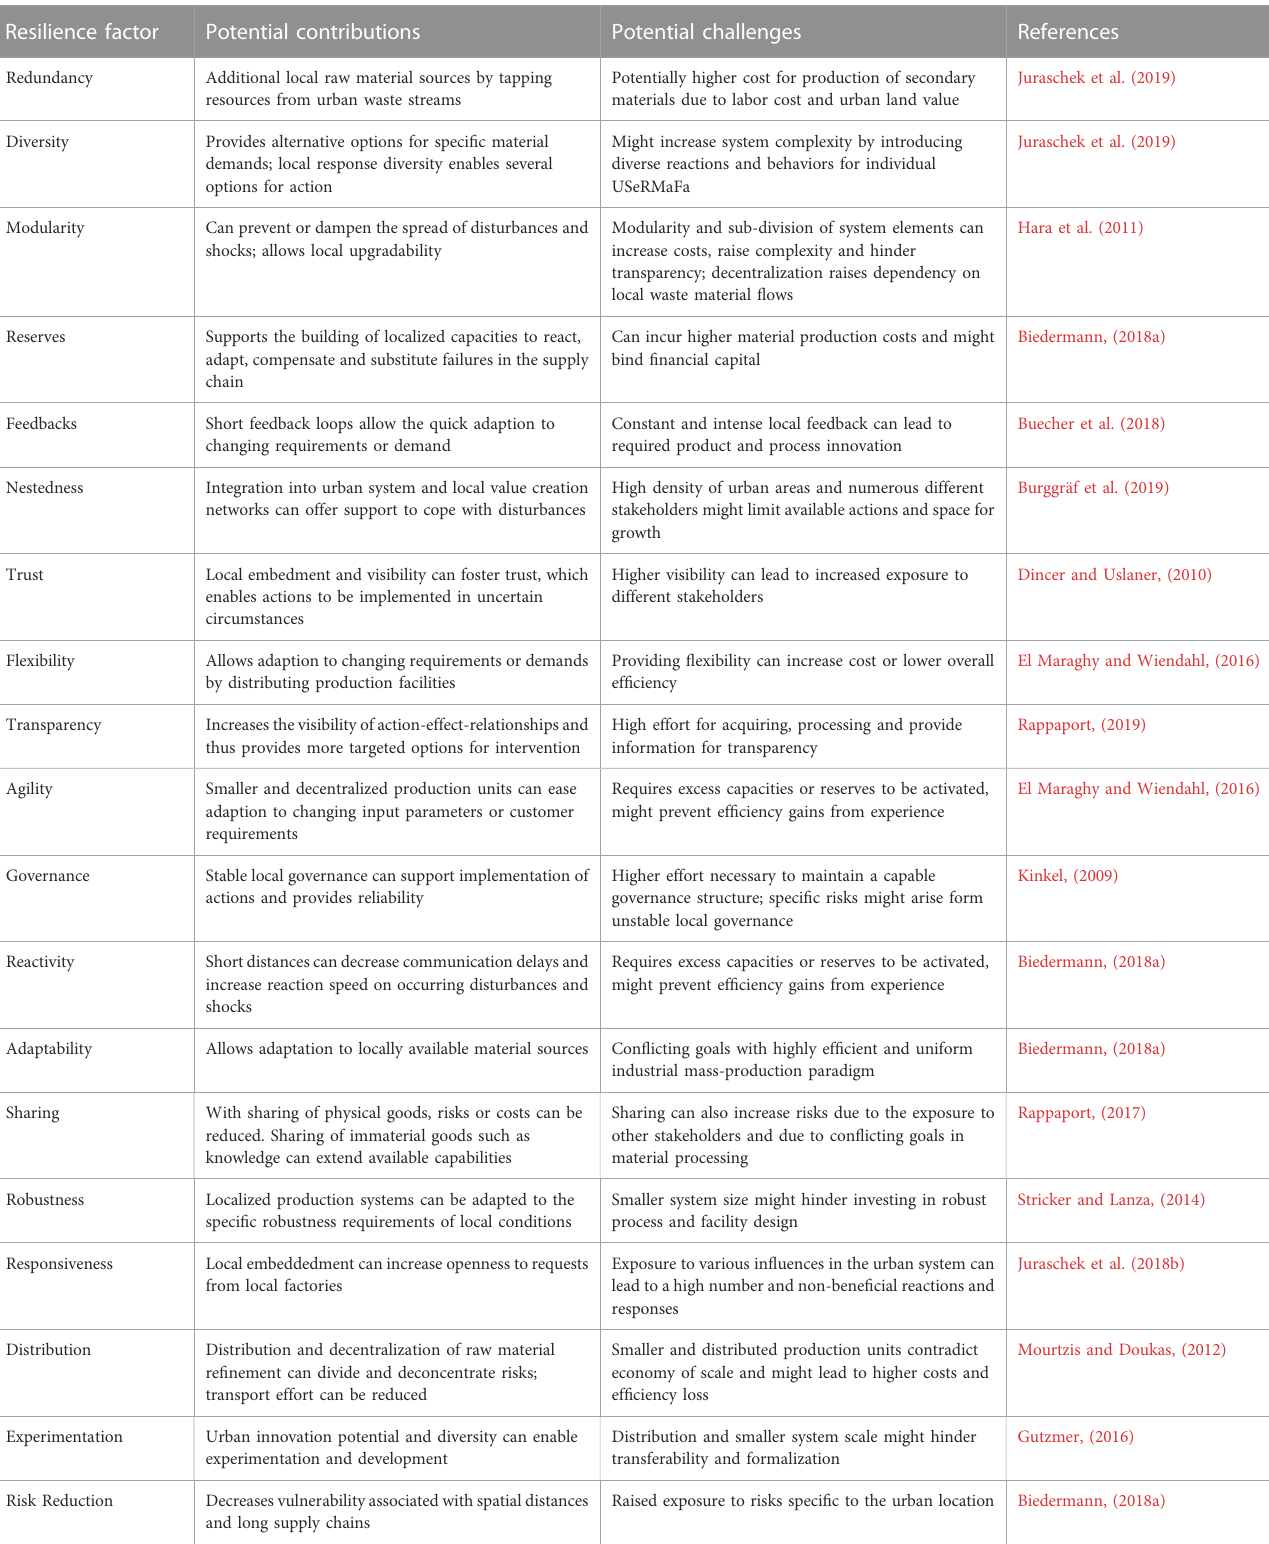
TABLE 1 In fl uence of USeRMaFas on resilience